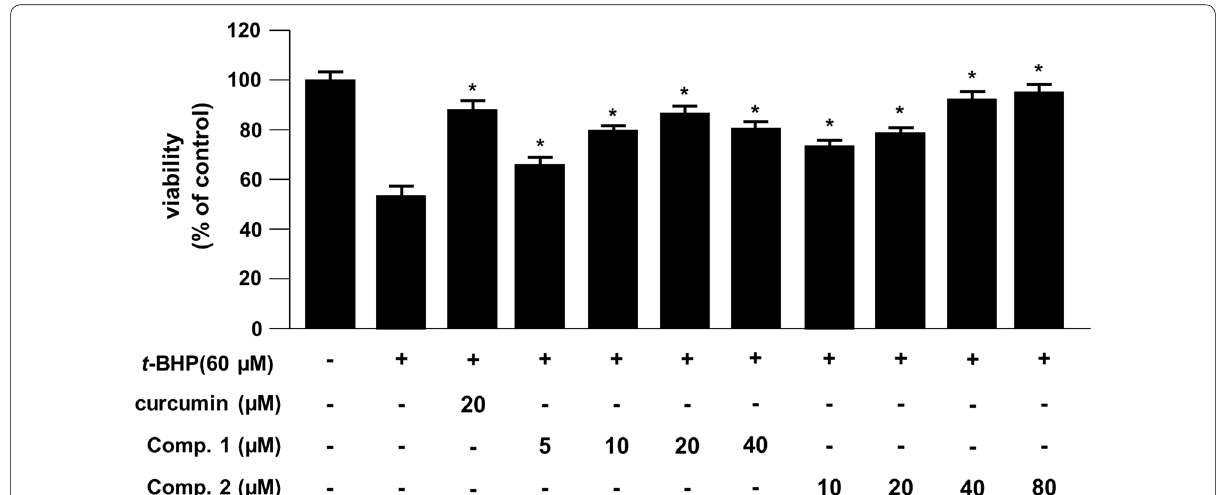
Fig. 3 Hepatoprotective activity against oxidative stress in t ‑BHP‑induced HepG2. Cytotoxicity was estimated after incubating the cells with 60 μM t ‑BHP in RPMI. The error bars represent the mean